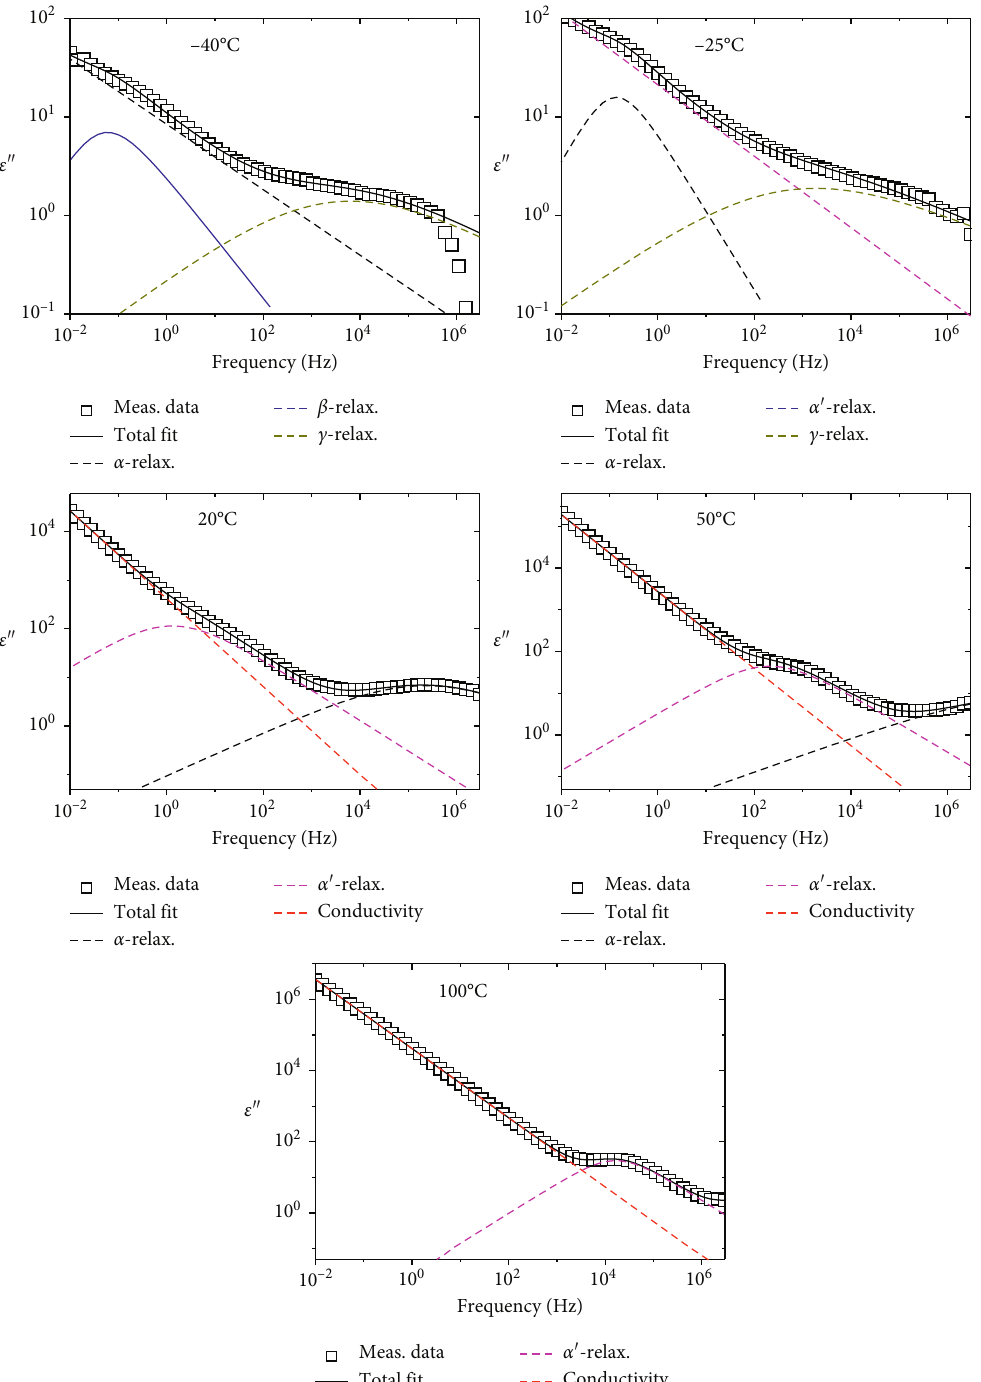
Figure 6: Simulation results for five representative temperatures within the range from − 40 ° C to 100 ° C. The total fitting results are presented with black solid lines through the data (open square), which are the sum of the black dashed line ( α -relaxation), blue dashed line ( β -relaxation), dark yellow dashed line ( c -relaxation), magenta dashed line ( α ’-relaxation), and red dashed line